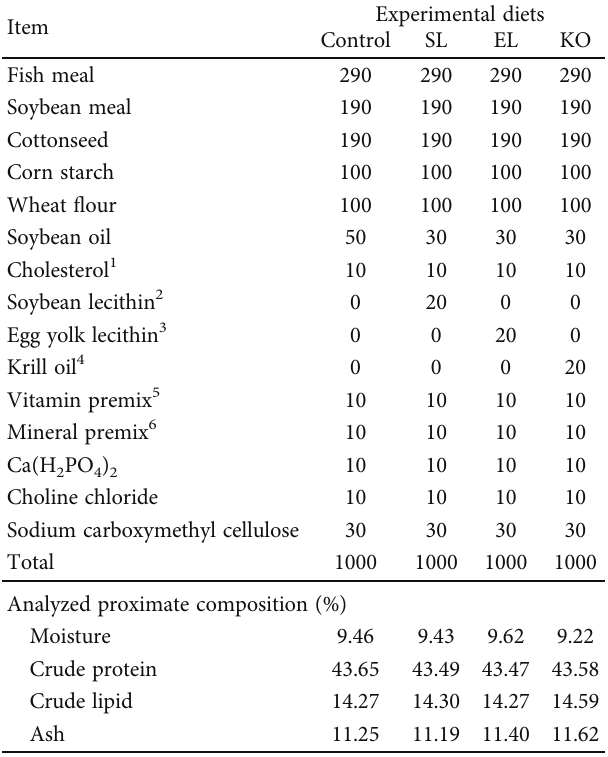
Table 1: Ingredient formulation (g/kg dry matter) and analyzed proximate composition (%) of the four practical experimental diets with di ff erent phospholipids fed to female Cherax quadricarinatus